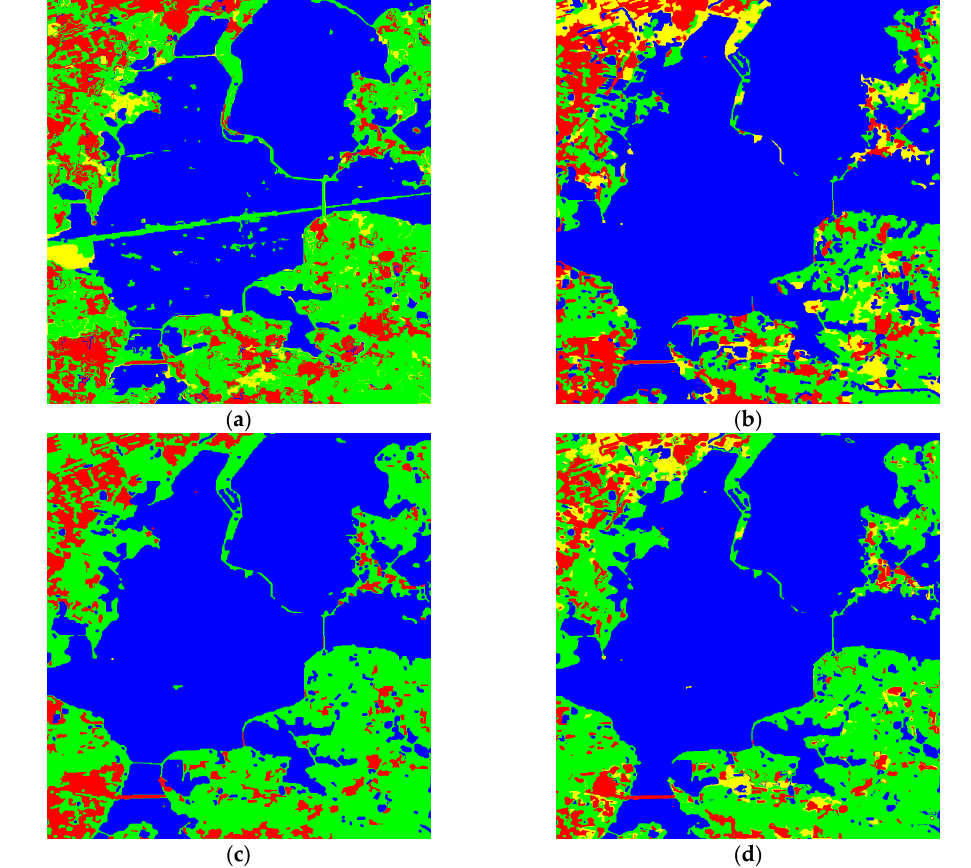
Figure 17. Classification results for the RadarSat-2 imagery with the different classification algorithms: ( a ) KNN classifier; ( b ) Wishart classifier; ( c ) LOR-LBP classifier; ( d ) RF classifier.